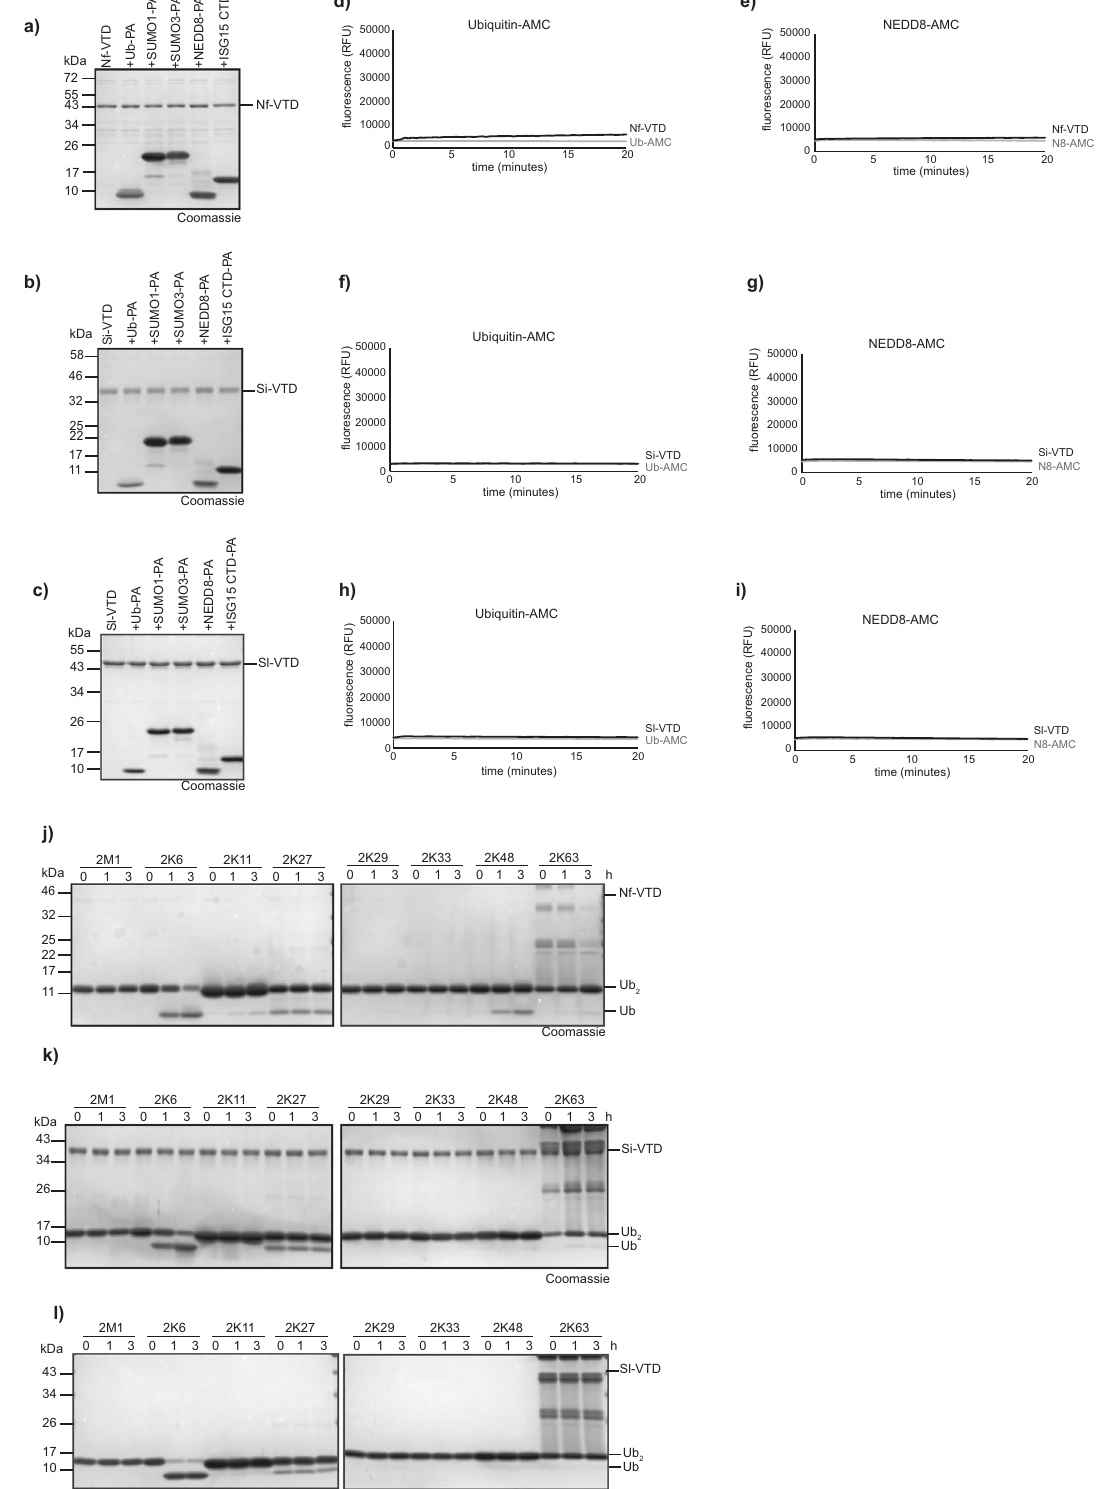
AMC ( d ) and NEDD8-AMC ( e ). The RFU values are the means of triplicates. j – l Linkage speci fi city analysis of eukaryotic VTDs. A panel of homotypic di- ubiquitin chains was incubated with Nf-VTD ( j ), Si-VTD ( k ) or Sl-VTD ( l ) for the indicated time points. Source data are provided as a Source Data fi